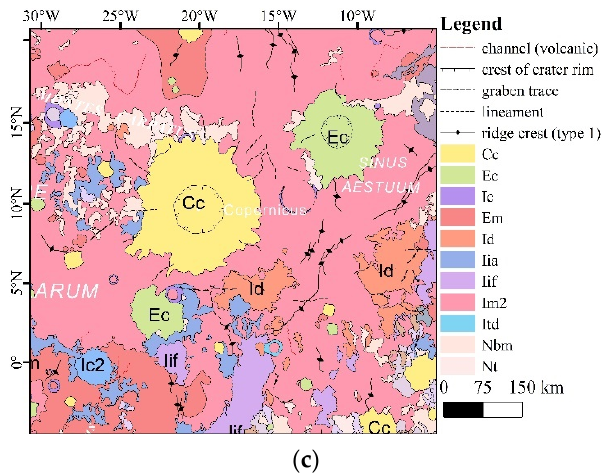
Figure 1. Copernicus crater and the surrounding area. ( a ) Copernicus area on a LROC WAC Global Morphology Mosaic; ( b ) Copernicus area on a LROC WAC DTM GLD100; ( c ) Copernicus area on a “Unified Geologic Map of the Moon, 1:5M, 2020”.